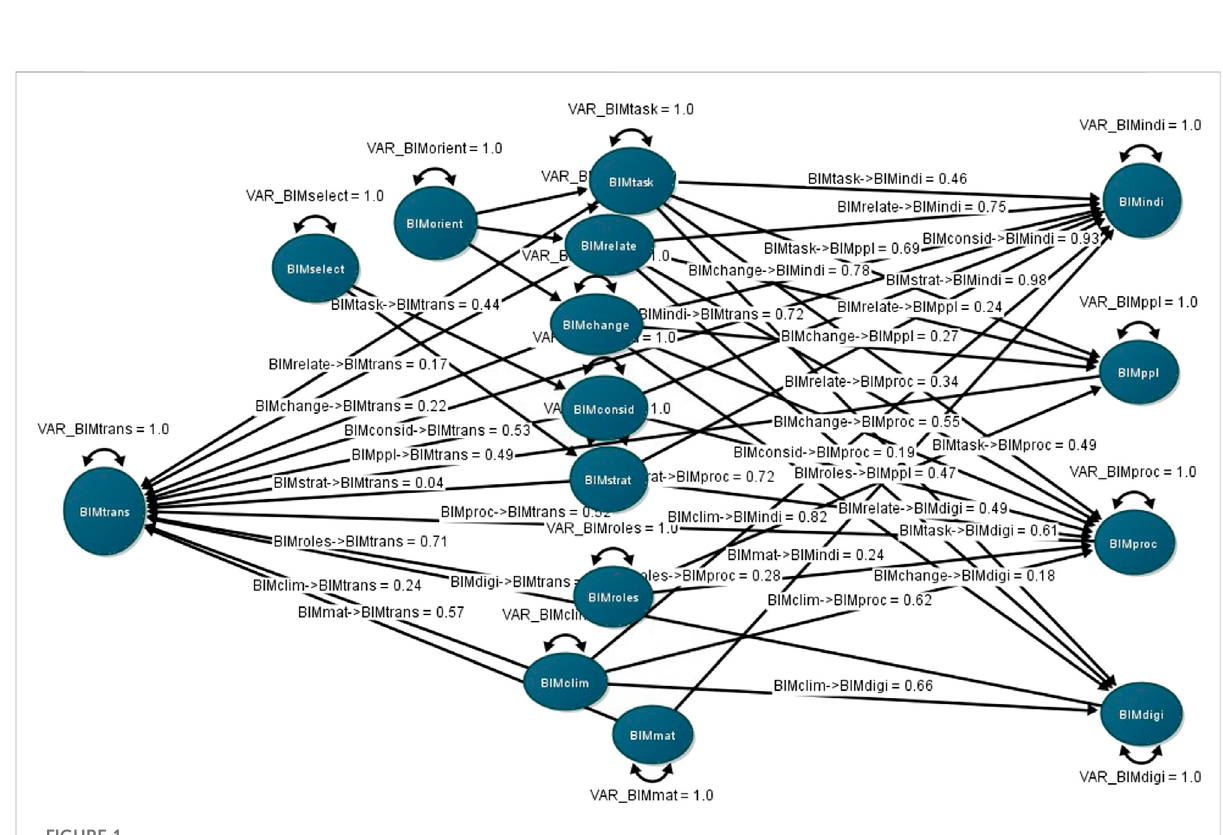
FIGURE 1 Validated model of BIM leadership for organisational BIM